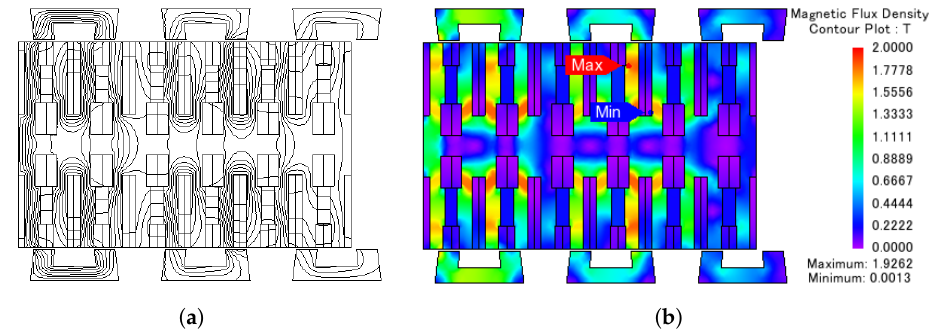
Figure 5. Flux linkage (both PM and DC excitation) ( a ) flux lines, ( b ) contour plot. Table 2. Different combinations and their respective